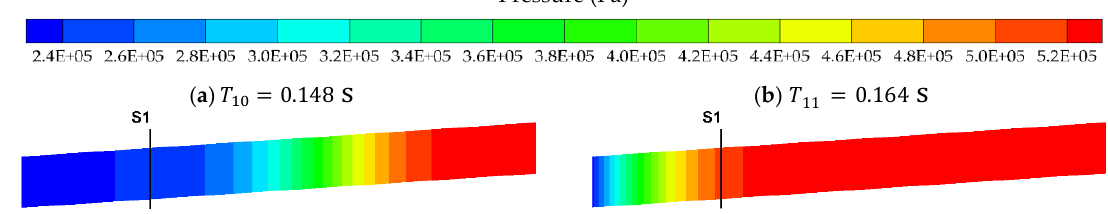
Figure 24. Pressure field evolution on the axis plane of the pipeline ( 𝑇 10 = 0.148 s and 𝑇 11 = 0.164 s ).